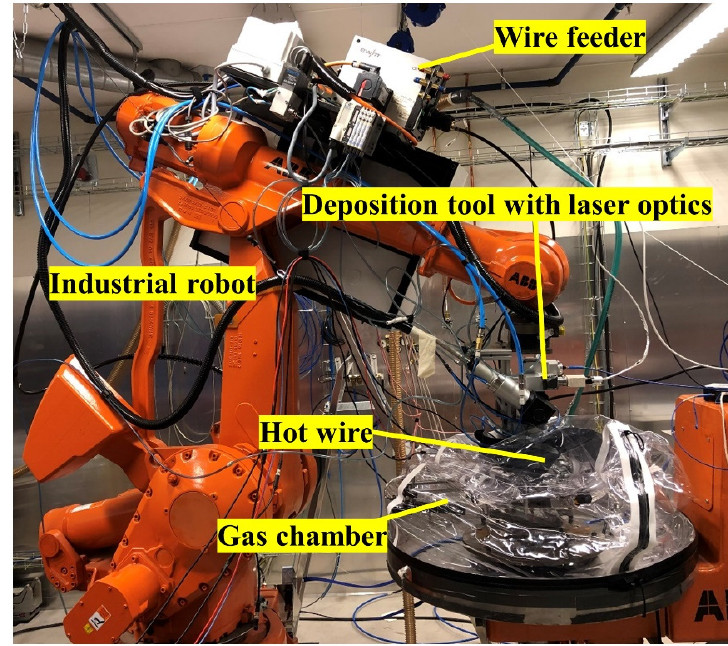
Figure 2. Laser Metal Deposition